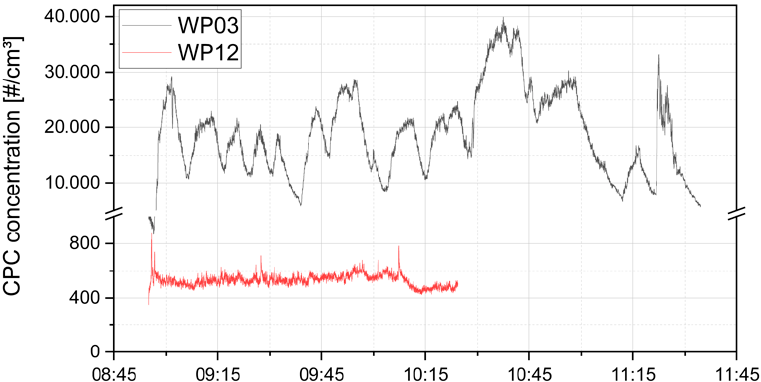
Figure 6. Particle number concentration as measured with the CPC during WP03 and WP12. For WP03 4 L/min and for WP12 6 L/min were used for filter sampling.